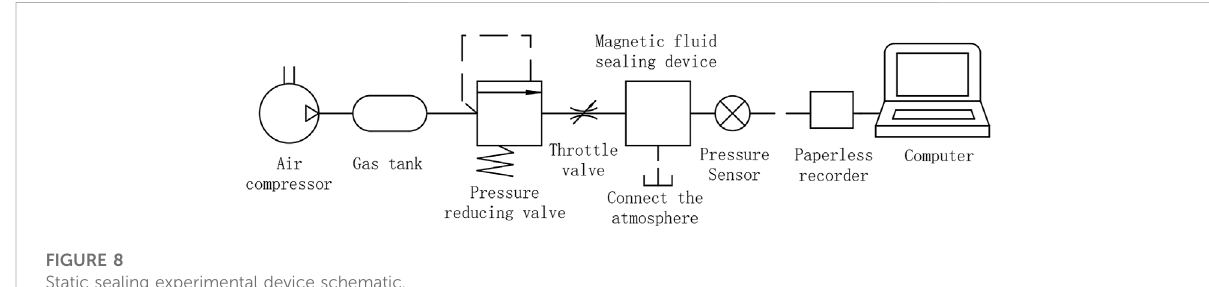
FIGURE 8 Static sealing experimental device schematic.